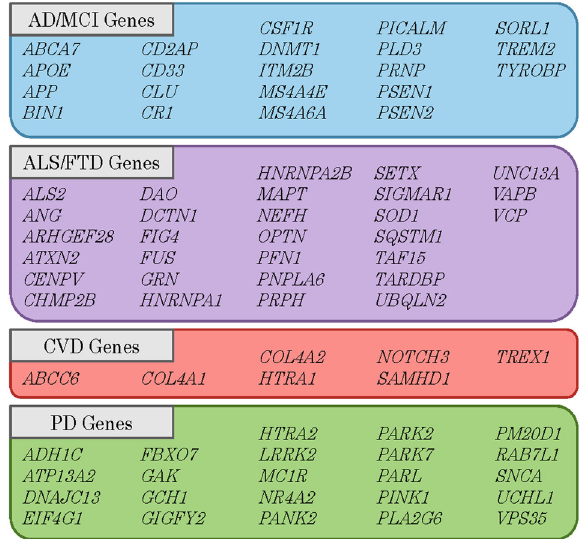
Fig. 2 Binning of genes included on the ONDRISeq next- generation sequencing panel. Genes were binned based on the most well-established previous disease association, as determined by Farhan et al. 34 , for use in the rare variant association